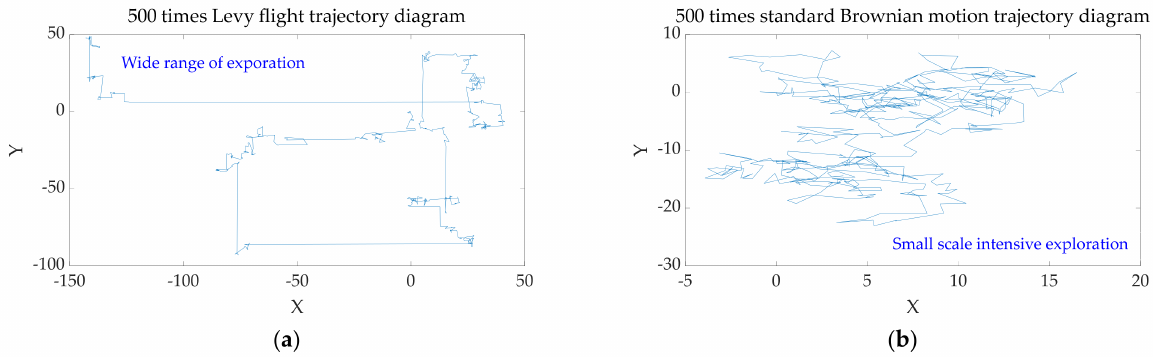
Figure 2. Schematic diagram of two kinds of random walk trajectory, with number of steps = 500. ( a ) Levy flight with the characteristic of wide exploration range; ( b ) Standard Brownian motion with the characteristic of high exploration